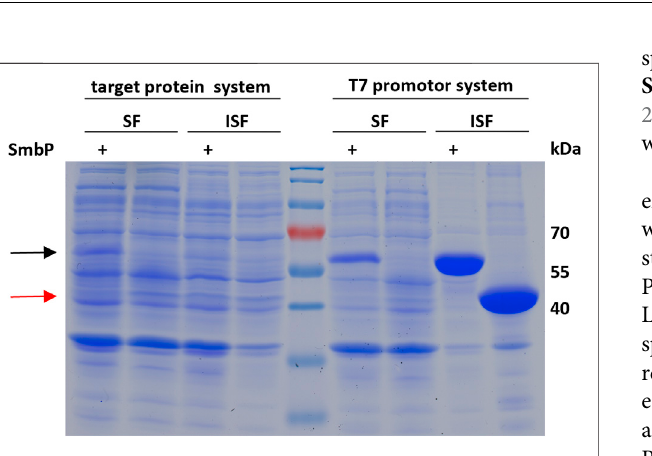
Frontiers in Bioengineering and Biotechnology |